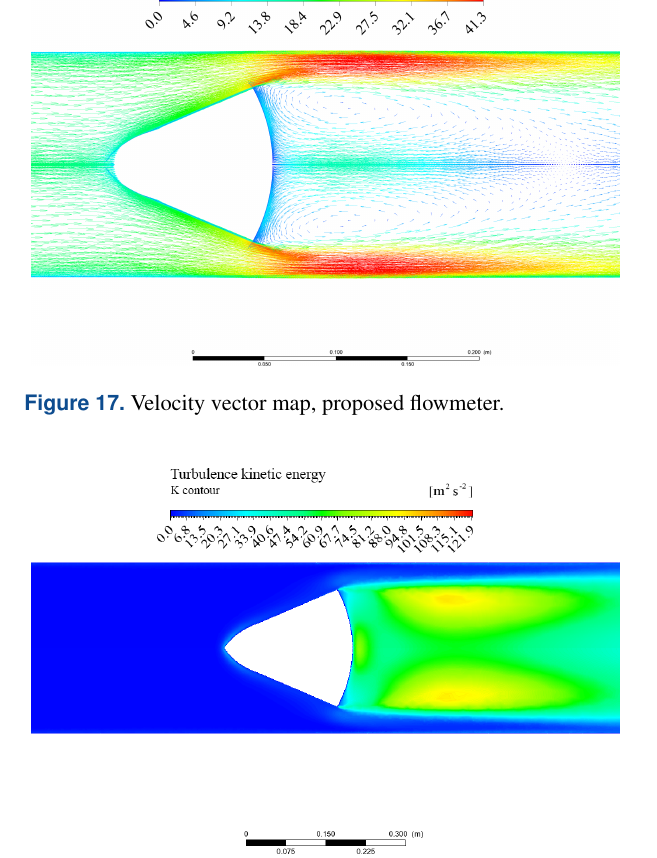
Figure 18. K contour plot, S-G